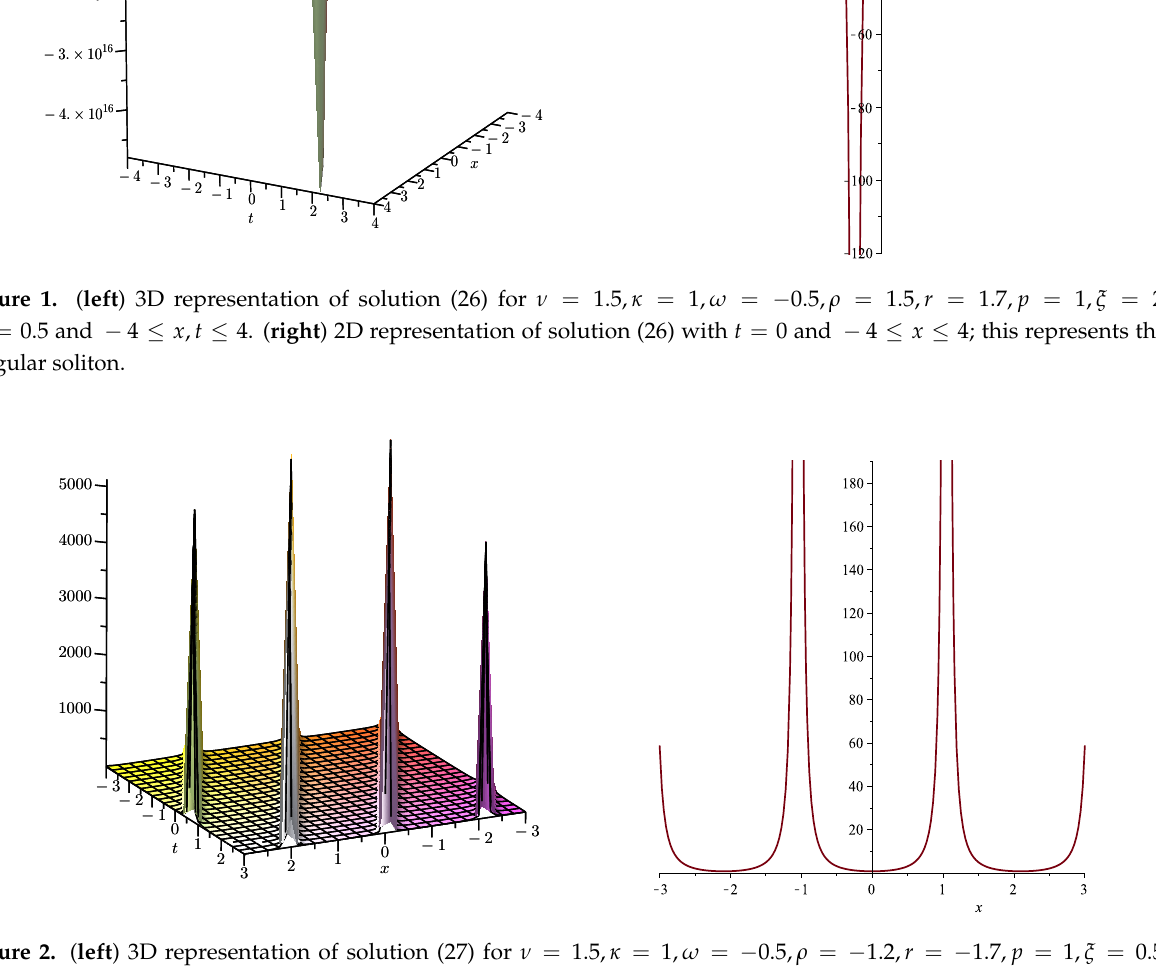
x , t 3 3. ( right ) 2D representation of solution (27) for t = 1 and − ≤ ≤